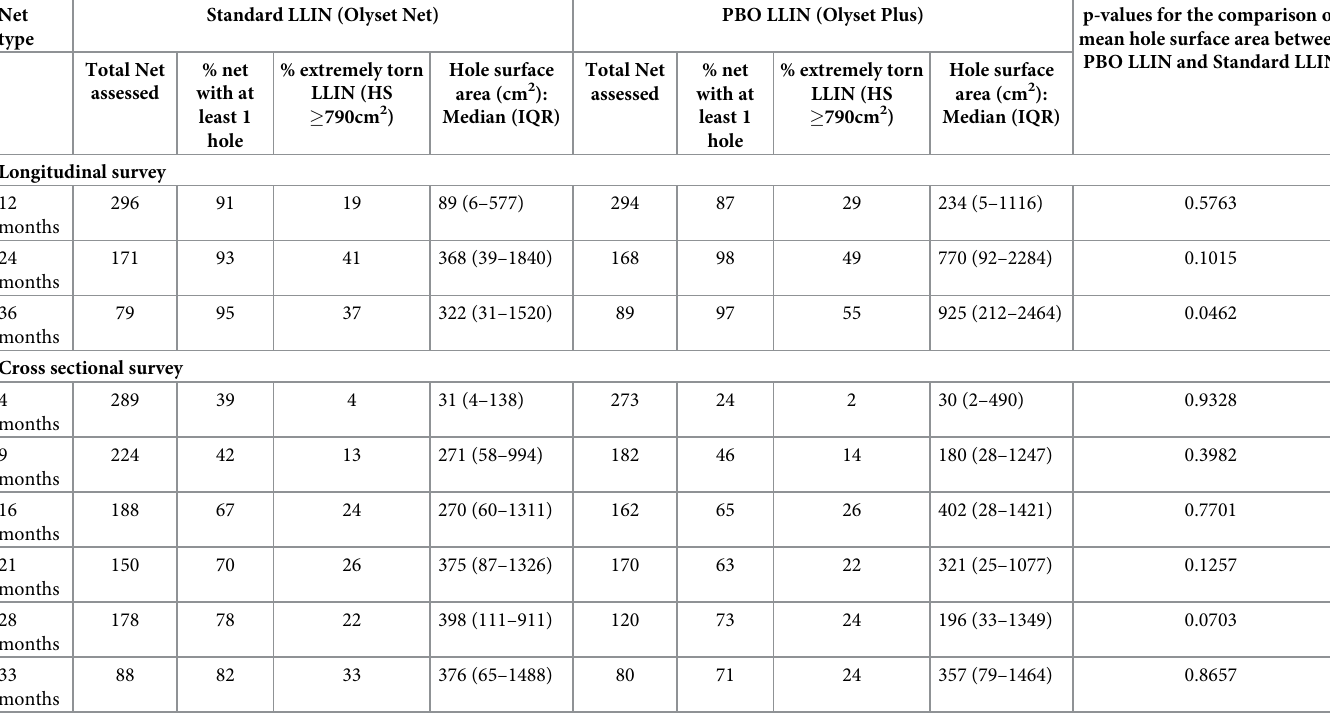
Table 4. LLIN physical durability expressed by hole surface area by survey (cross-sectional and longitudinal) and net age. Net Standard LLIN (Olyset Net) PBO LLIN (Olyset Plus) p-values for the comparison of type